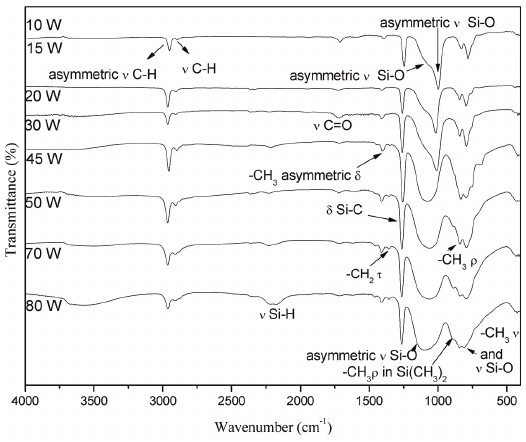
Figure 4. Infrared spectra of films prepared with discharge powers ranging from 10 to 80 W. The symbols ν, δ, ρ and τ mean stretching, deformation, rotation and scissors, respectively.